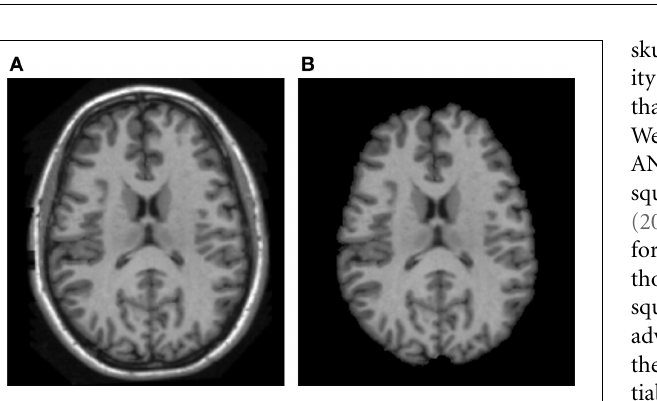
MULTI-ATLAS-BASED SEGMENTATION WITH ATLAS SELECTION Image